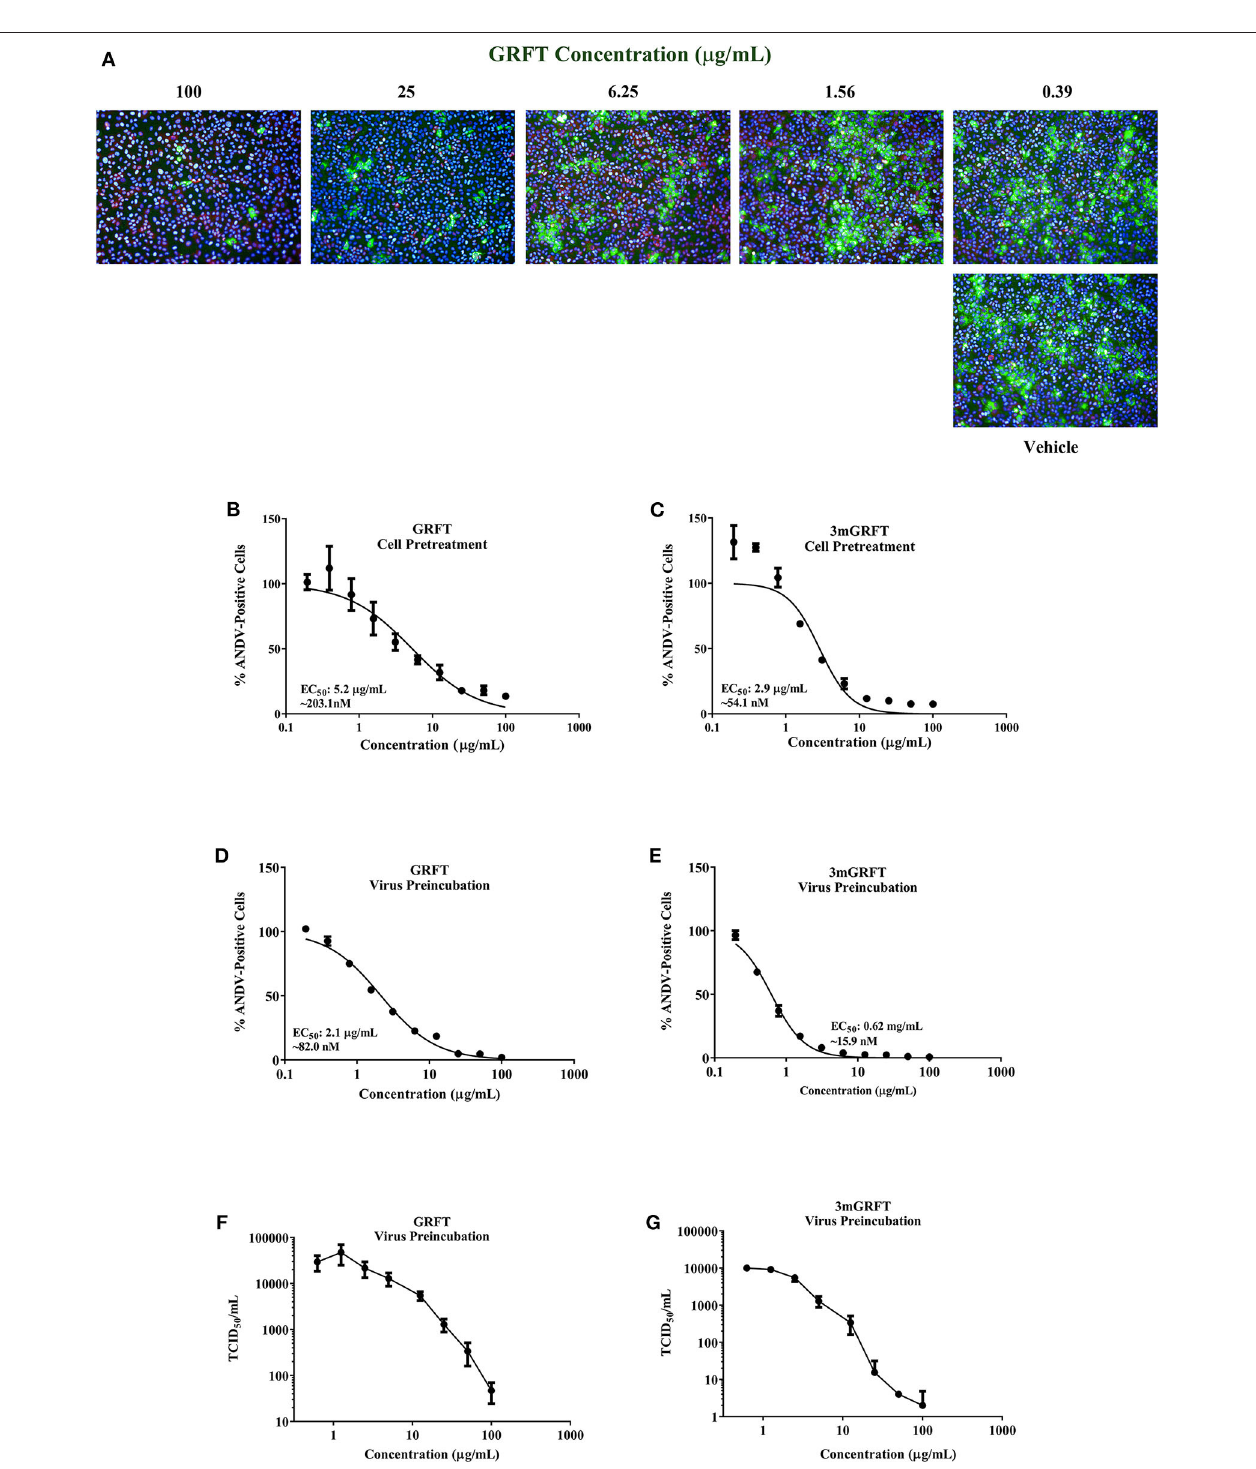
FIGURE 1 | Griffithsin inhibits Andes virus replication. Griffithsin (GRFT) inhibited Andes virus (ANDV) replication in a concentration-dependent manner. (A) Vero-E6 cells were treated for 1h with varying concentrations of GRFT before infection with ANDV at a multiplicity of infection (MOI) of 0.1. At 72h post infection, the cells were fixed, permeabilized, and stained with an antibody against Puumala virus nucleoprotein that is cross-reactive with ANDV nucleoprotein. Green, ANDV nucleoprotein; blue, cell nuclei; red, cell cytoplasm. (B,C) Dose-response curve showing the quantitation of ANDV-infected cells after GRFT (B) or 3mGRFT (C) treatment (% normalized to the vehicle-only control). (D,E) Inhibition (neutralization) of ANDV by GRFT. Increasing concentrations of GRFT were pre-incubated with 2,000